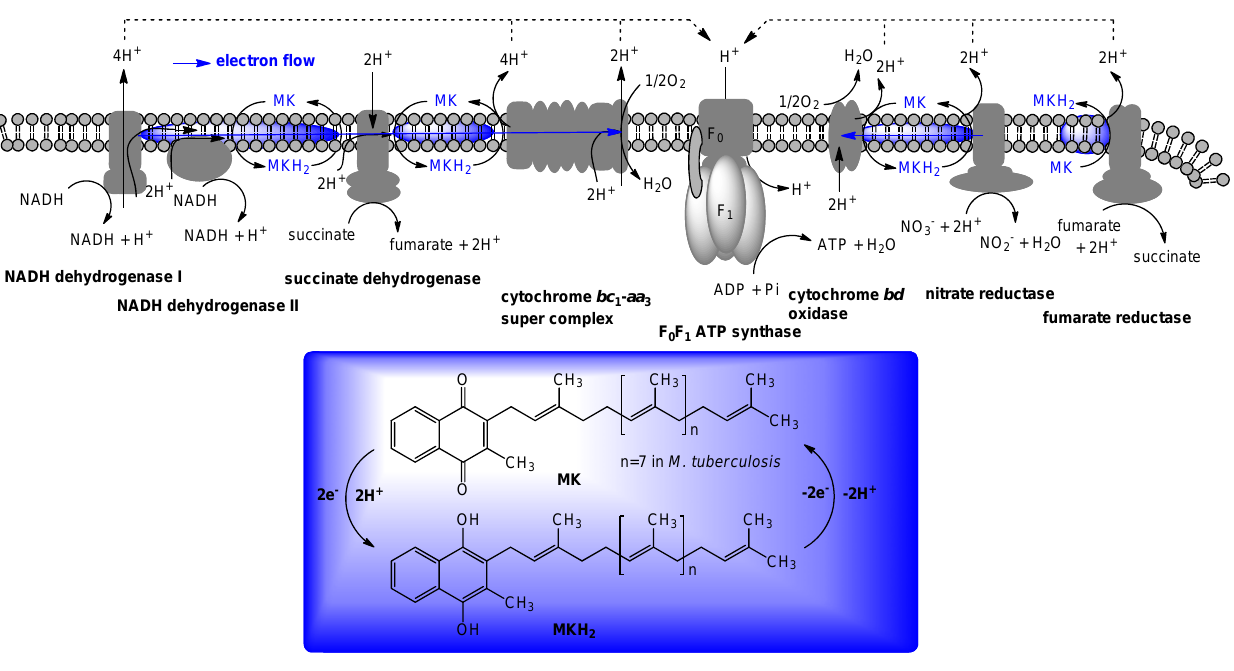
Figure 3. The electron flow system from M. tuberculosis as example of menaquinone mediated energetic